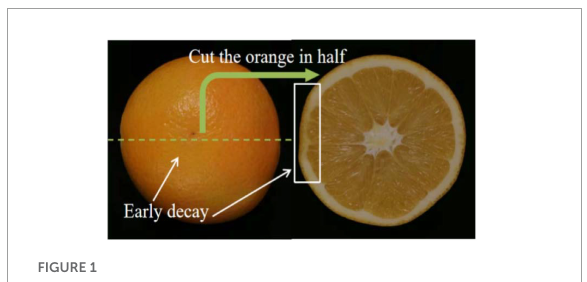
FIGURE1 Orange sample with early